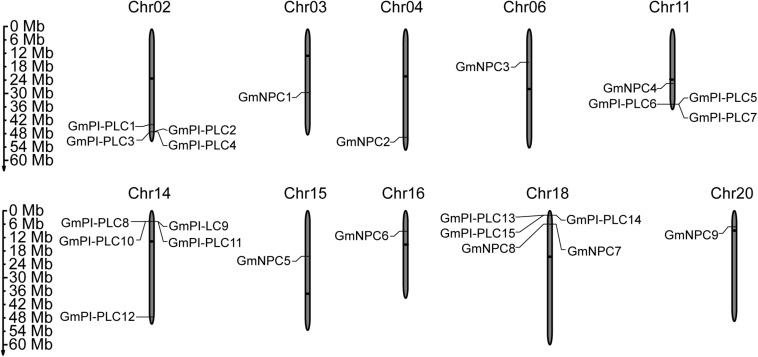
Chromosomal distribution of the identified 15 GmPI-PLC genes and 9 GmNPC genes in soybean. The members of GmPLC genes were distributed on different chromosomes (Chr). The gray bars represent the Chrs, and the Chr numbers are shown above the bars. Bars are not drawn to scale. The numbers on the left side of the bars show the distances in megabases (Mb) between neighboring genes.